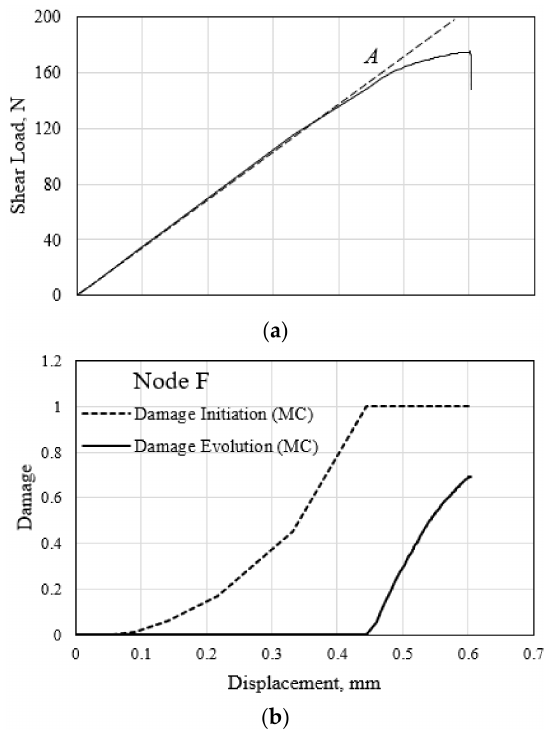
Figure 20. ( a ) Shear load–displacement response, and ( b ) characteristic evolution of the compressive matrix damage variables at the critical material point